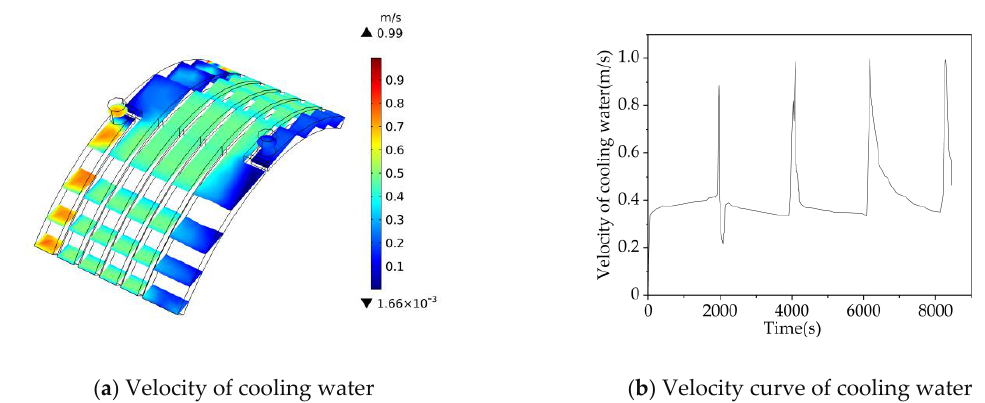
Figure 18. Cooling water velocity and velocity variation curve of IWM.